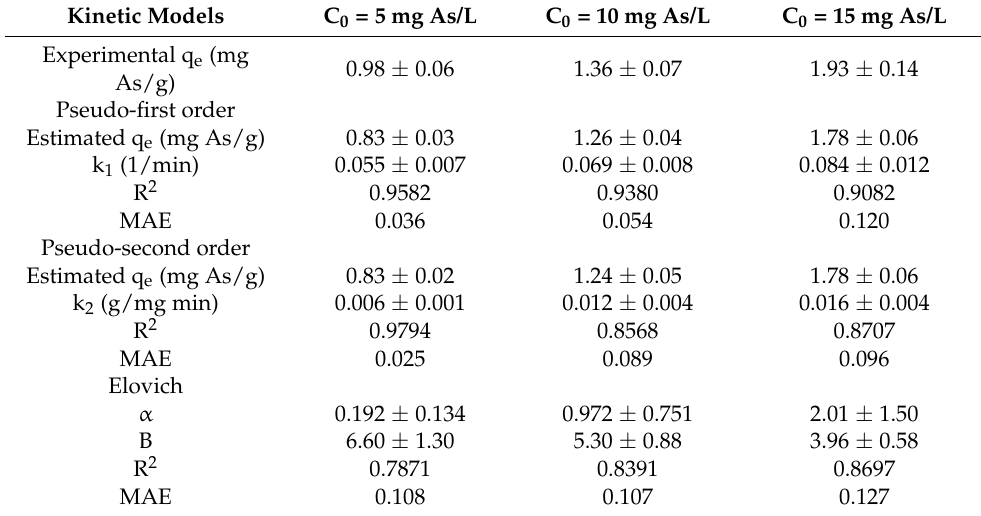
Table 1. Kinetic data of As adsorption by ChM hydrogel beads at 25 ◦ C and initial pH = 7.0, using different initial concentrations of arsenic. The adsorption capacity is expressed in milligrams of As per gram of dry